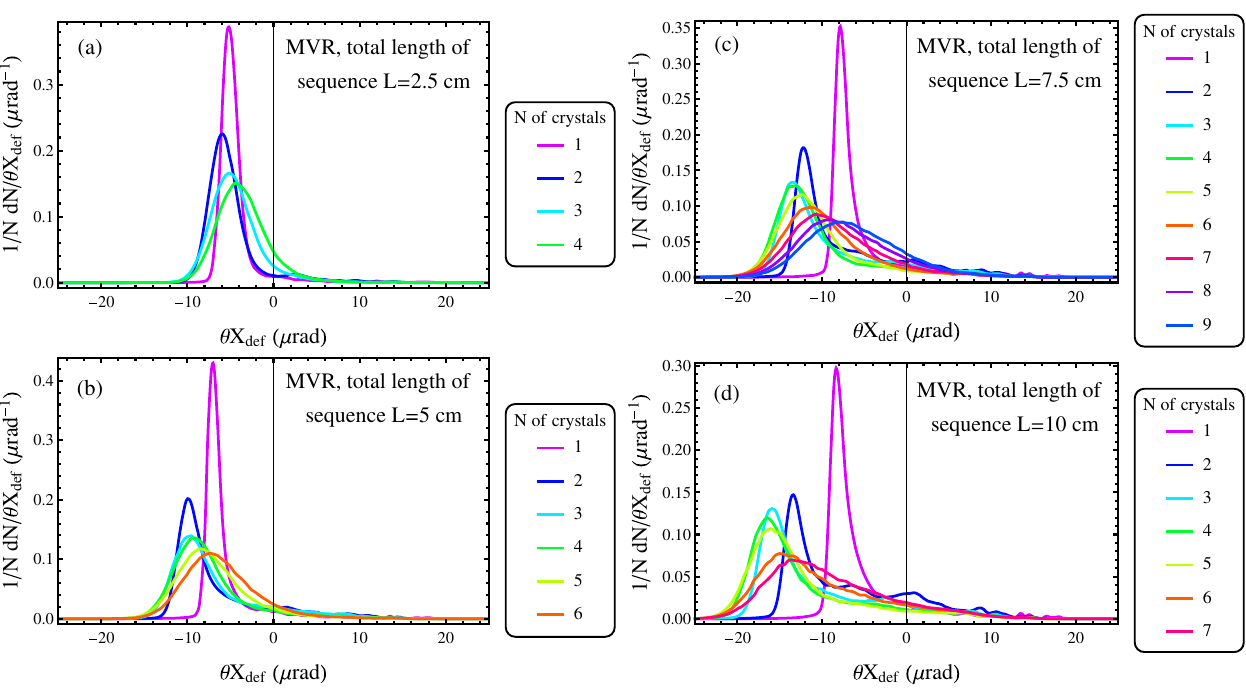
FIG. 7. Angular distribution behind the crystal for MVROC of 50 TeV protons in one and in a sequence of h 111 i bent silicon crystals. The alignment and geometry of crystals are calculated according to (7) –